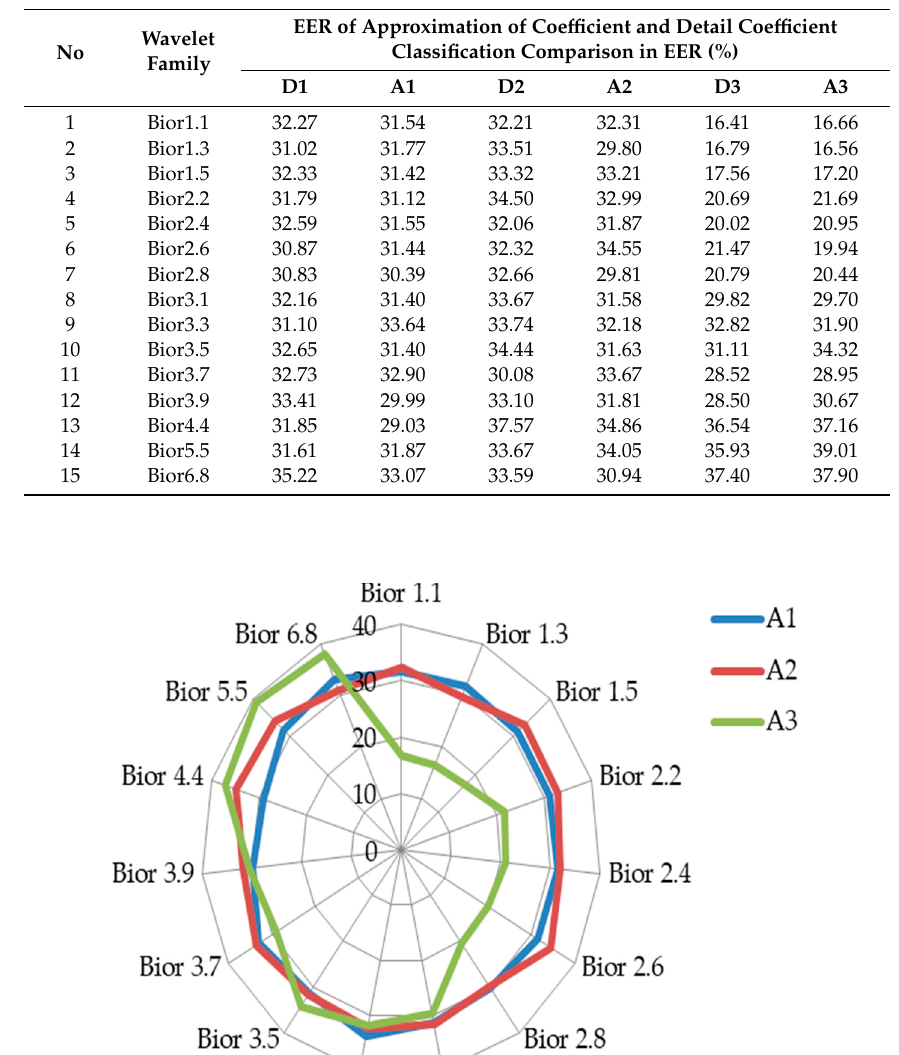
Table 2. The three sub-band levels of approximation of coe ffi cient and detail coe ffi cient (A1: approximation of coe ffi cient sub-band1; A2: approximation of coe ffi cient sub-band 2; A3: detail